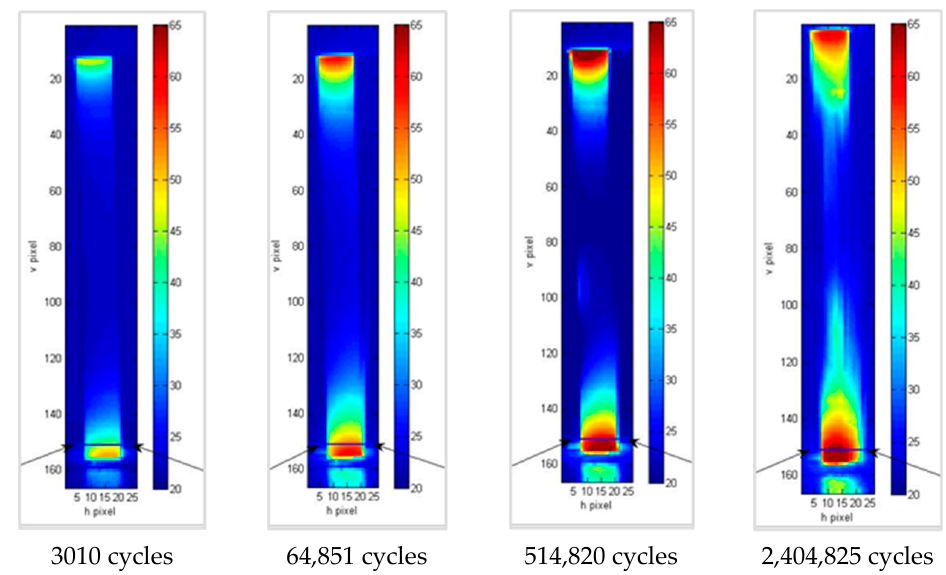
Figure 7. Thermograms at different loading cycles for specimen 1b.